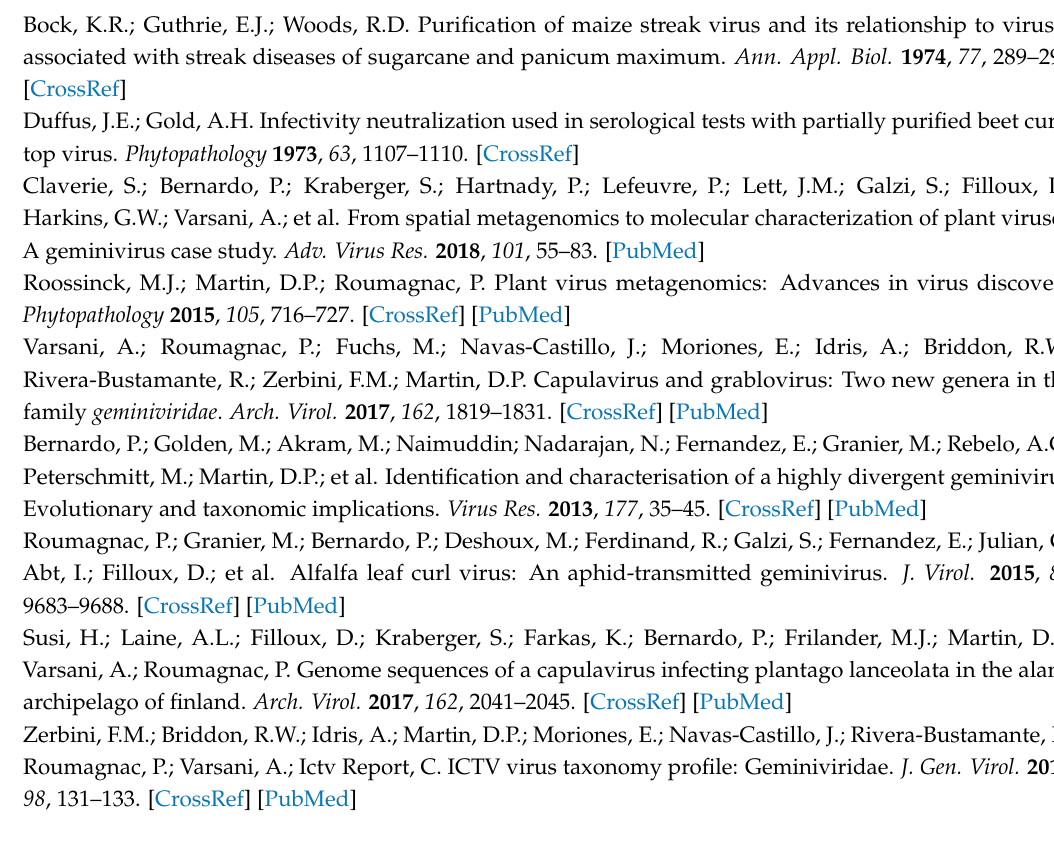
s1, Table S1: Features of the 120 ALCV isolates analyzed in this study. Figure S1: Pairwise identity frequency distribution plot of 120 complete genome sequences of alfalfa leaf curl